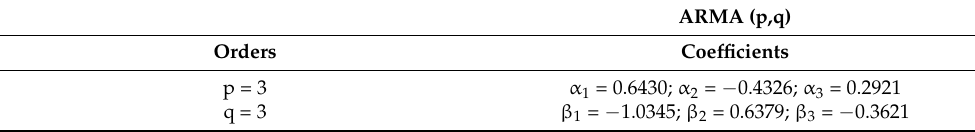
Table 4. Parameters of the ARMA model for a summer Figure 8. Evolution of solar radiation in W/m 2 for a summer day.